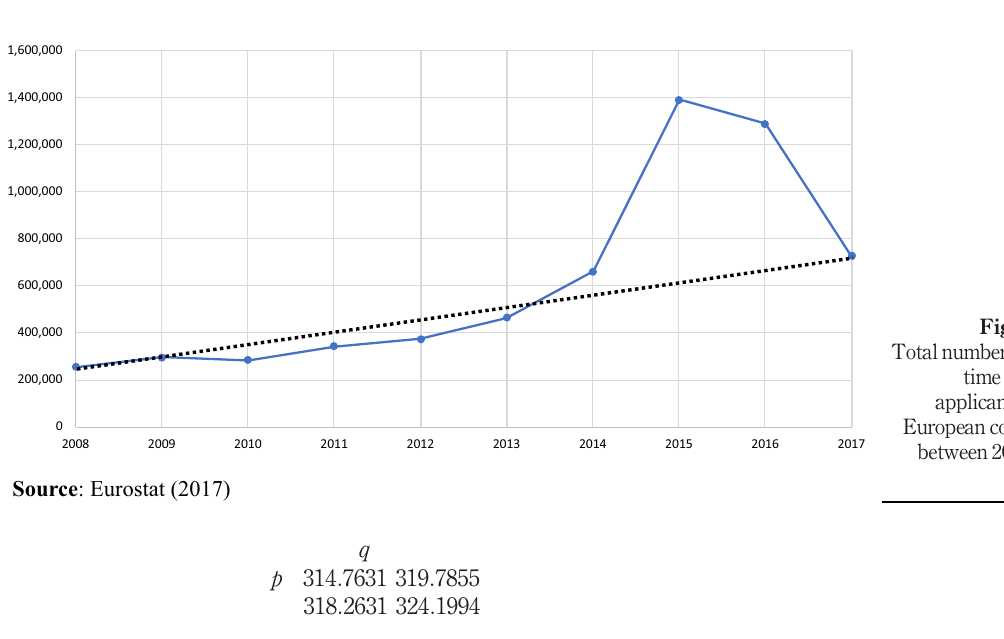
Figure 8. Number of fi rst-time asylum applicants in 2017 in 30 European